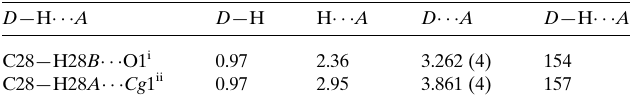
Table 1 Hydrogen-bond geometry (A˚ , (cid:3) ) for